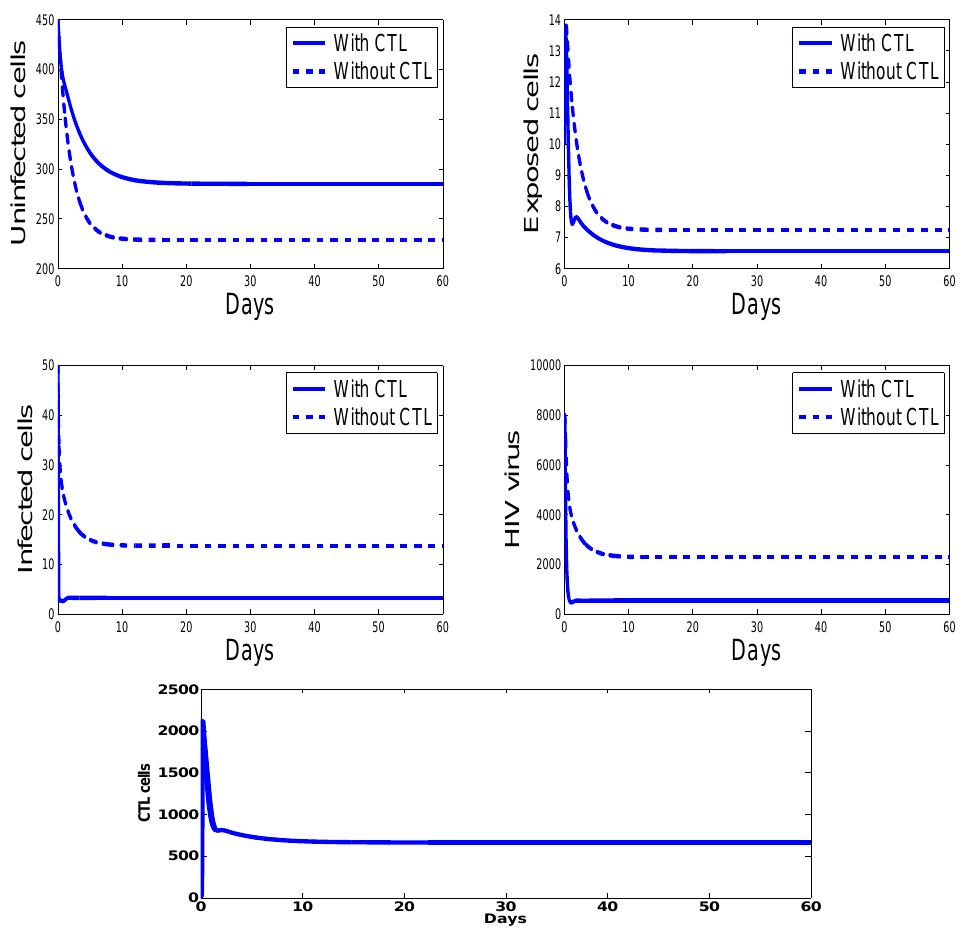
Figure 6. The behavior of the infection dynamics for λ = 10, d 1 = 0.0139, k 1 = 0.04, d 2 = 0.0495, k 2 = 1.1, d 3 = 0.5776, a = 100, d 4 = 0.6, p = 0.0024, c = 0.15, b = 0.5. For the chosen parameters in this figure, we have R 0 = 11.049 > 1 and R CTL = 4.13 > 1. Solutions tending to the infection steady